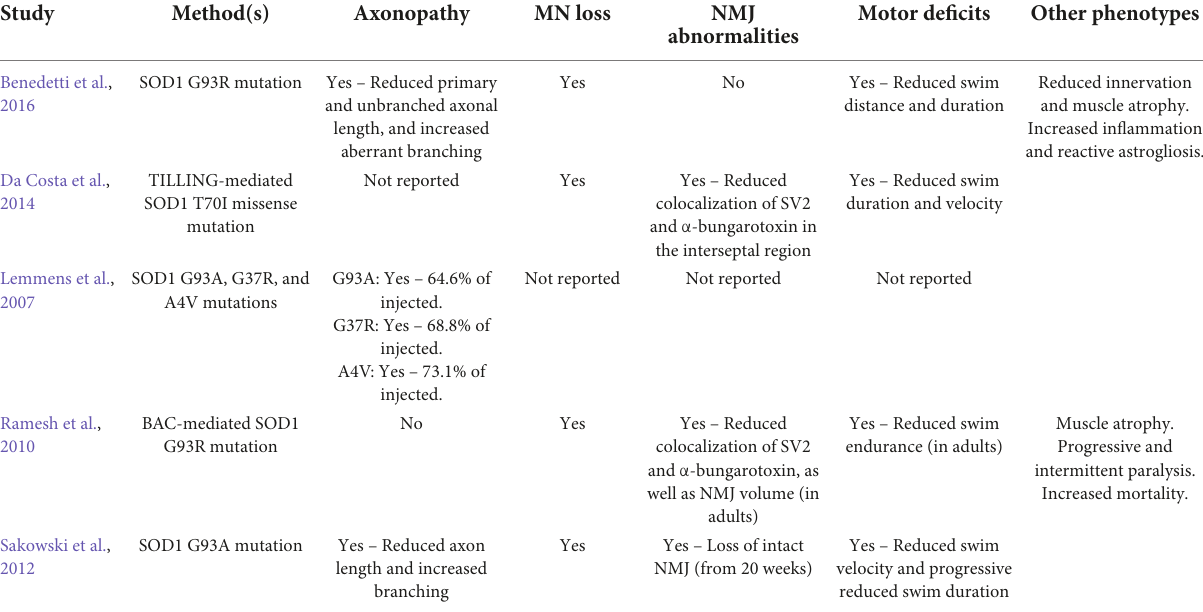
TABLE 5 Zebrafish models of SOD1